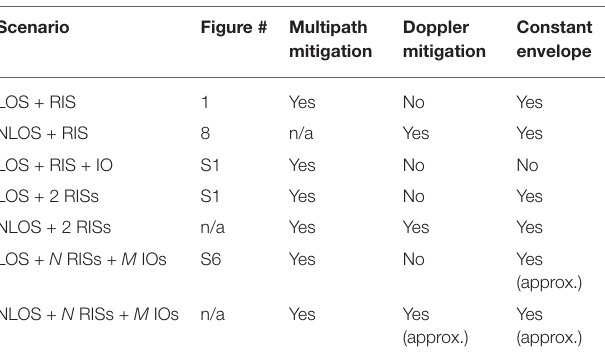
TABLE 1 | Comparison of different RIS application scenarios. Scenario Figure # Multipath